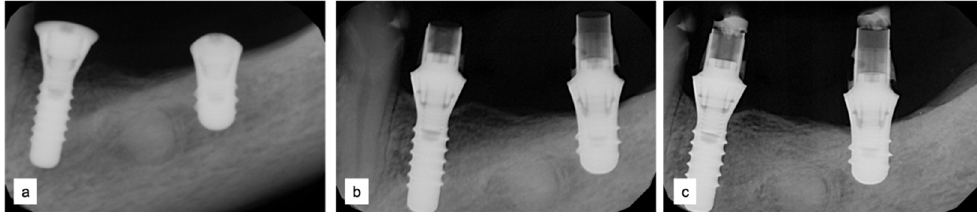
Figure 9. Periapical radiographs ( a ) immediately after implant placement (Institute Straumann, Basel, Switzerland), ( b ) after 12 months, and ( c ) after 18 months of prosthetic loading.